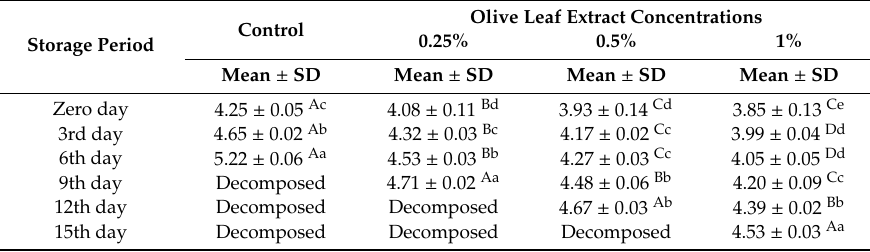
Table 5. Pattern of the aerobic bacterial count (log10 cfu / g) in poultry meat treated with di ff erent concentrations of olive leaf extract during the chilling storage period at 4 ± 1 ◦ C (mean ± standard deviation “SD”).